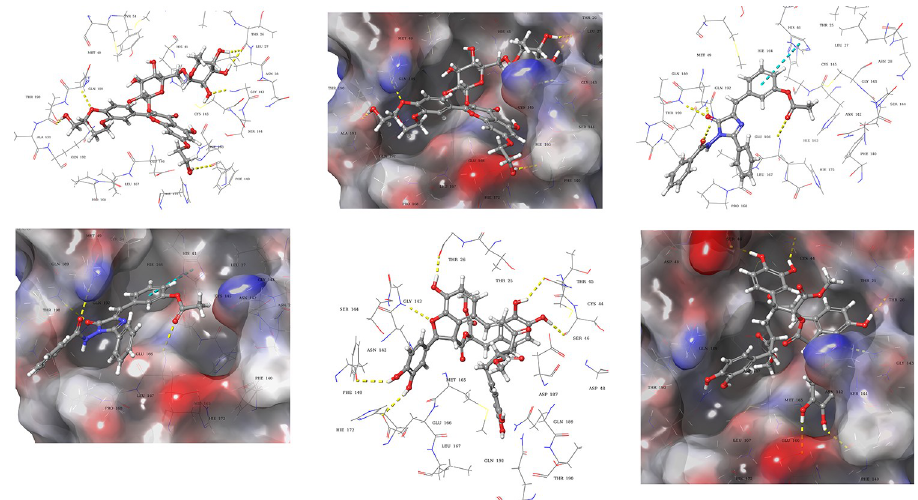
Fig 5. Docked poses and molecular interactions of compound 1, 2, and 3 in binding site of 6Y2F. 3D-Ligand interaction and 3D molecular surface diagrams of compounds 1 ( a ) and ( b ), compound 2 ( c) and ( d ) compound 3 ( e ) and ( f ), showing the docked pose in the binding site of 2019-nCOV 3CL hydrolase (Mpro). The hydrogen bonds, and π - π interaction are represented as yellow and blue dotted lines.